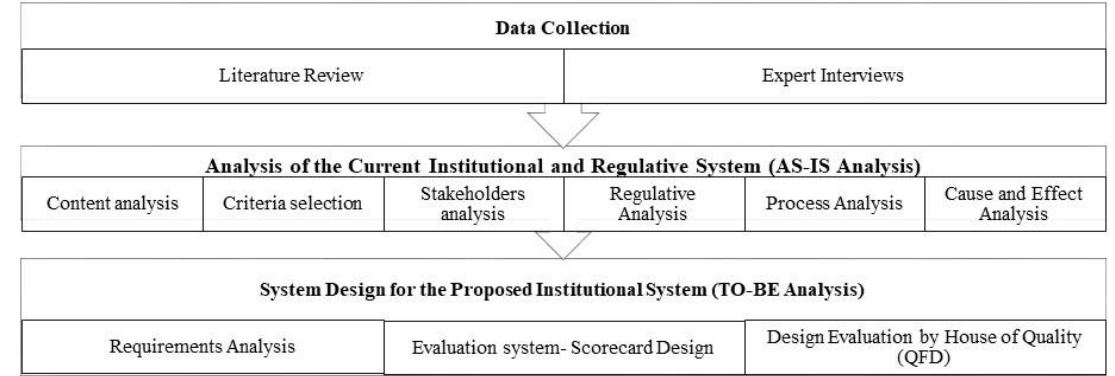
Figure 1. Methodology of the research.